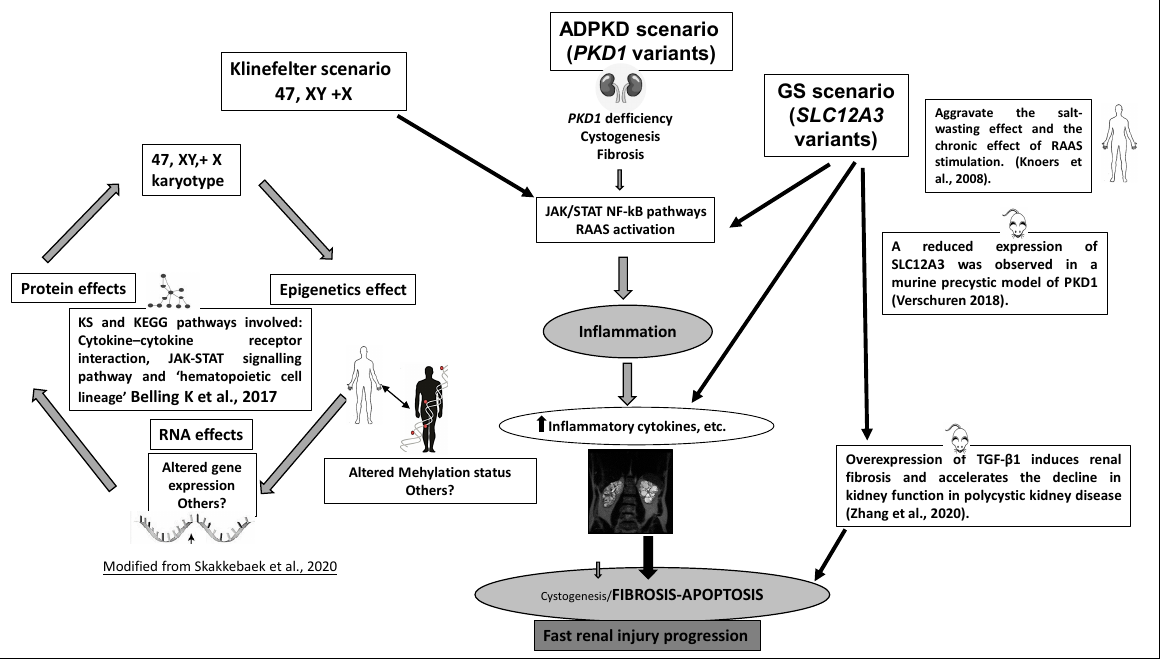
Figure 2. Hypothetical scheme for putative mechanisms on synergistic ADPKD pathogenesis and additional effects of KS and GS in our proband. Based in animal and human models of disease.